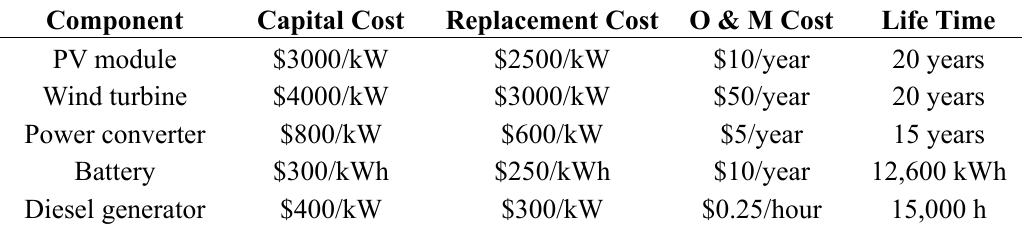
Table 1. Different costs of the components.